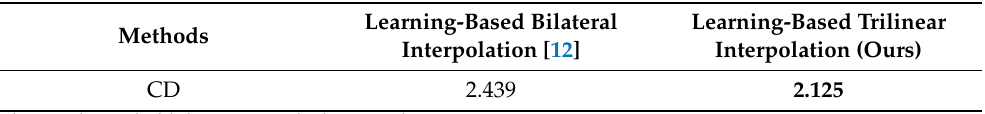
Table 7. Shape completion results (CD × 10 3 ) on learning-based bilateral interpolation and learning- based trilinear